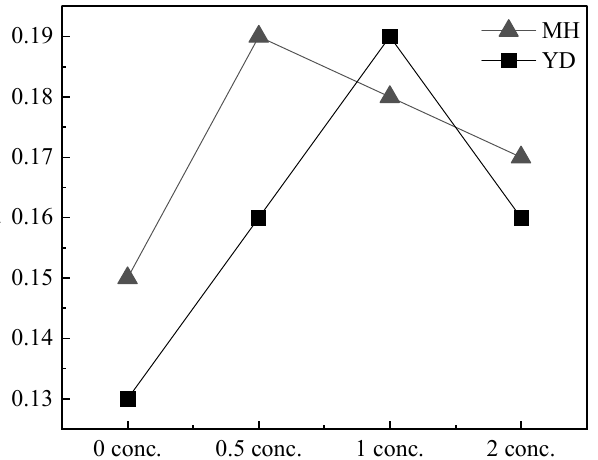
Figure 5. The ratio of fungi to bacteria at the jointing stage of rice (F/B): YD represents the YD; MH represents the MH.